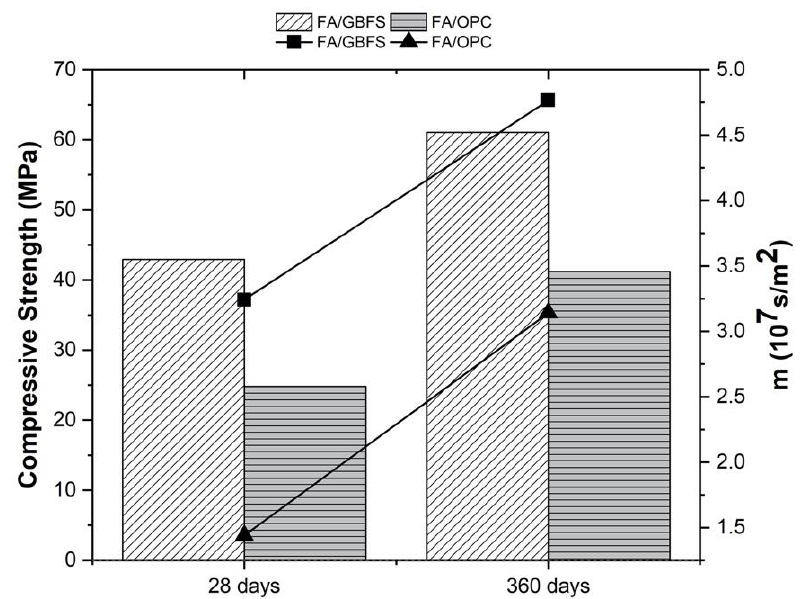
Figure 3. Compressive strength and Resistance to water penetration before being exposed to chlorides. a b